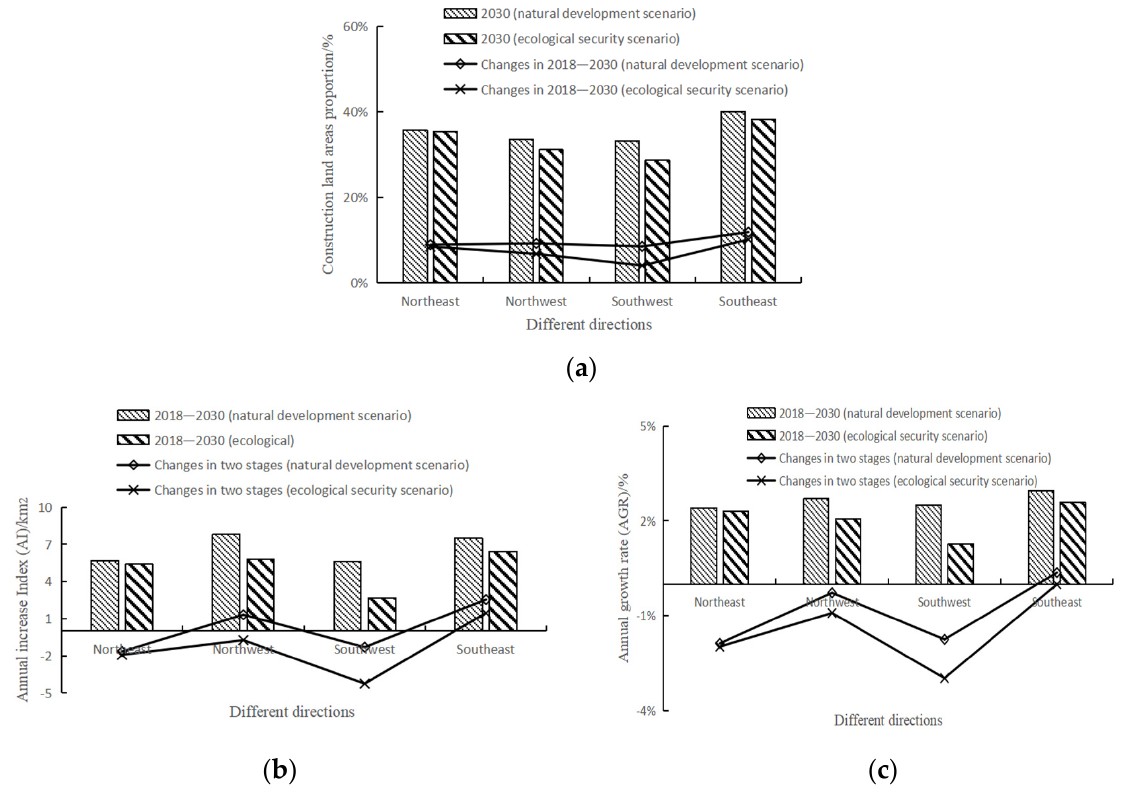
Figure 9. Characteristics of urban expansion in different directions under different scenarios: ( a ) construction land area proportion; ( b ) annual increase index (AI); ( c ) annual growth rate (AGR).